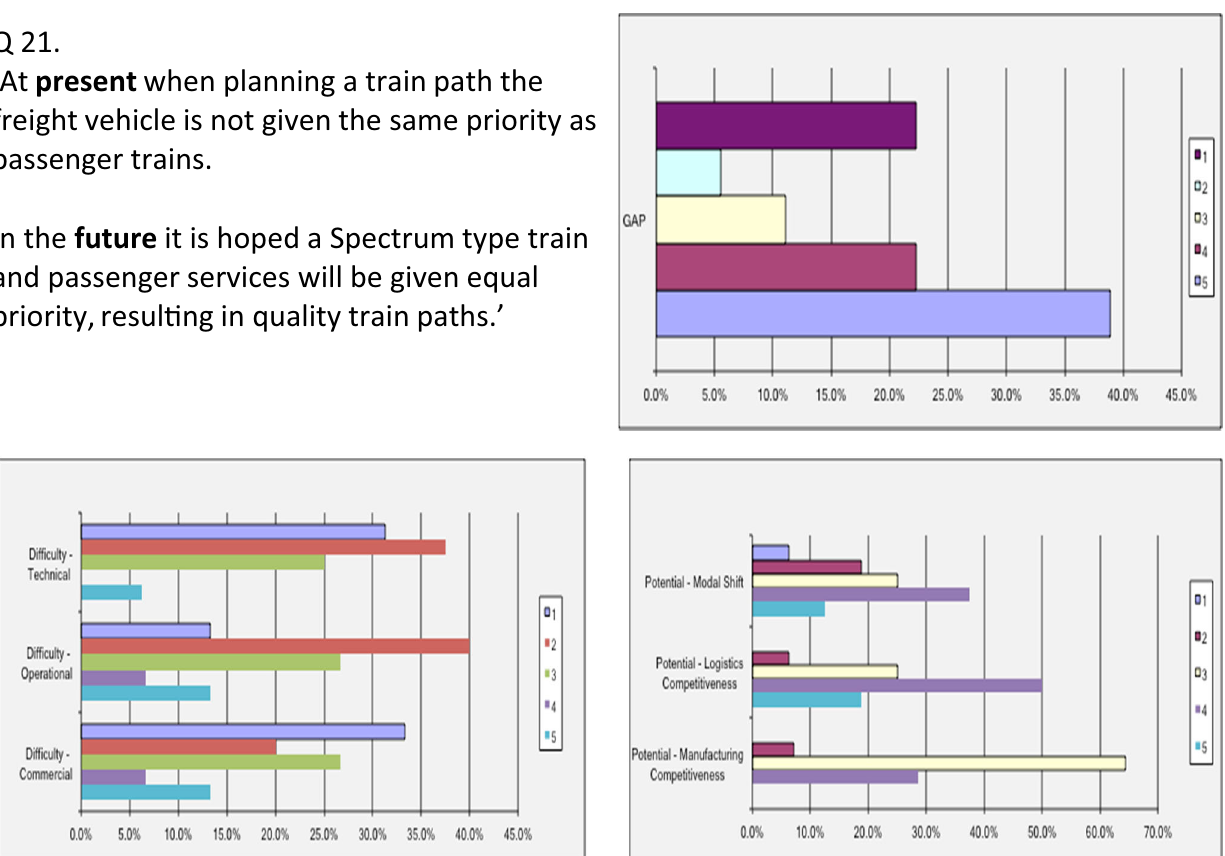
Fig. 3 Freight trains ’ path allocation priority similar to passenger